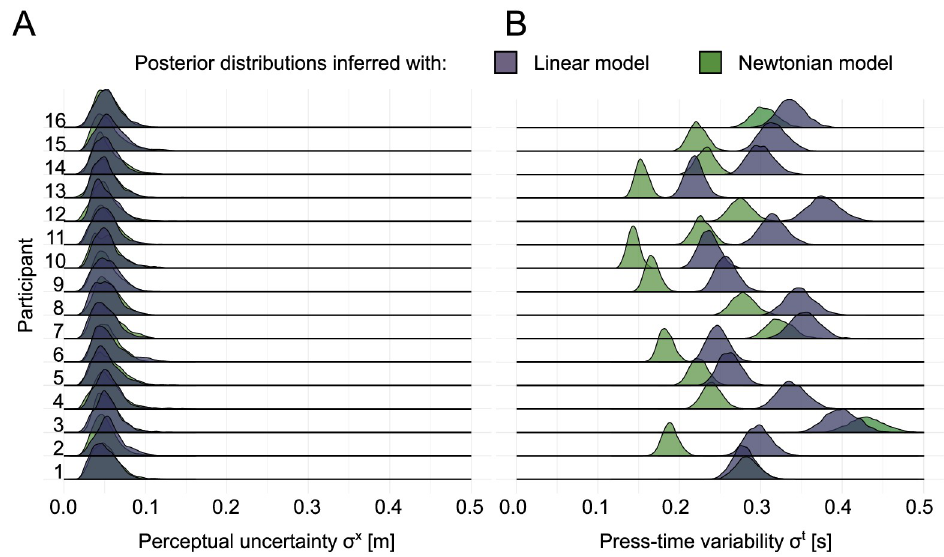
Fig 6. Posterior estimates of perceptual uncertainty and press-time variability inferred with data from phase two “feedback”. (A) Inferred posterior distributions of perceptual uncertainty for the linear heuristics model and the Newtonian physics model. Dark green distributions display posterior distributions for the Newtonian model class, dark blue ones for the linear model class. A separation into cost functions is not included since the different cost functions did not lead to significant differences. (B) Inferred posteriors for individual press-time variability varied significantly between subjects between the two models. All but one participant show lower or equal values of variability regarding the press-time for the Newtonian model